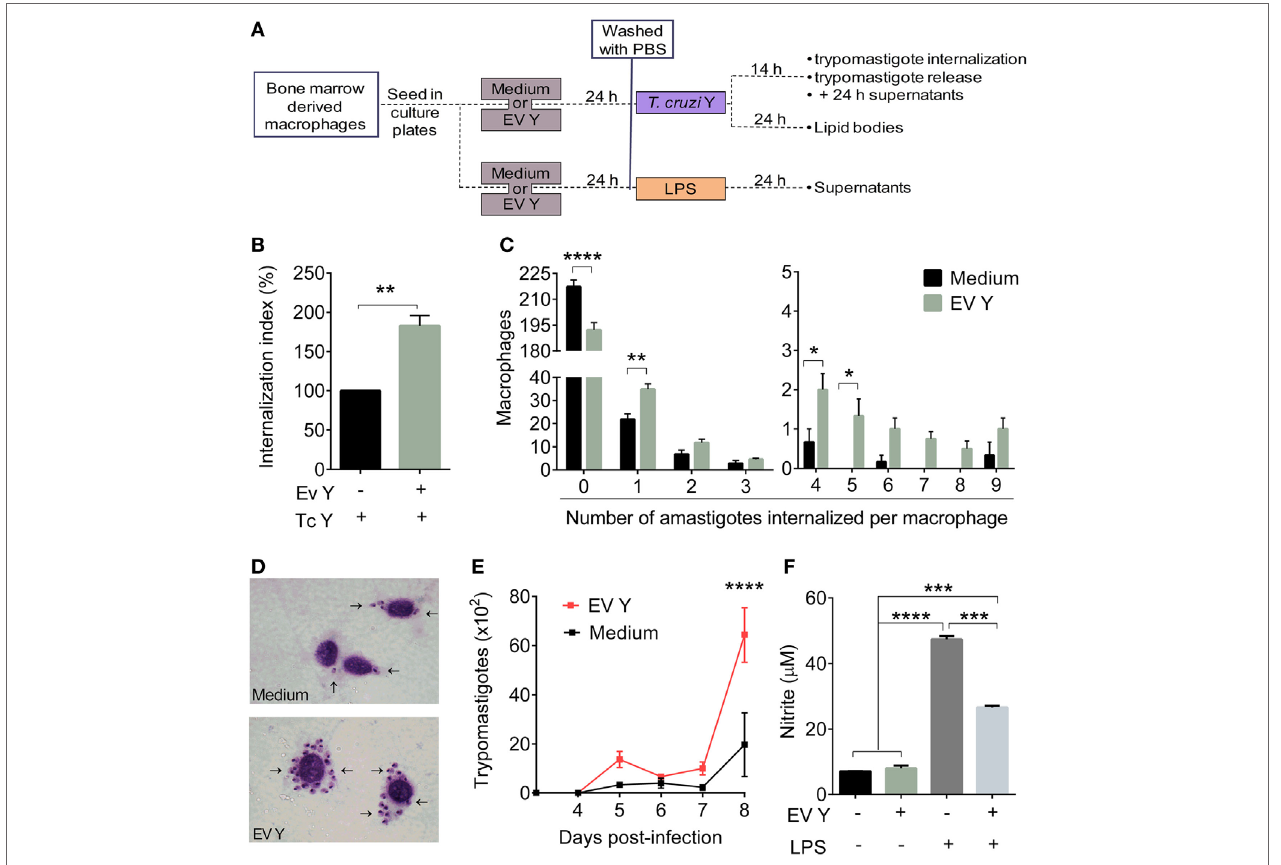
FigUre 6 | Macrophage in vitro stimulation with Trypanosoma cruzi extracellular vesicles (EVs) increases T. cruzi infection and trypomastigote release from infected cells but decreases nitric oxide release. Bone marrow-derived macrophages were incubated for 24 h with EVs derived from T. cruzi Y (EV Y) (i.p.). The cells were washed and infected with T. cruzi trypomastigote forms (0–1 parasites per macrophage for the trypomastigote release assay and 5 parasites per macrophage in the remaining assays) for 14 h or stimulated with 0.1 µg/mL of LPS for 24 h. After the clearance of non-internalized parasites, the cells were stained with Giemsa and analyzed by light microscopy. (a) Experimental design for macrophage in vitro assays (B) The internalization index was calculated considering the number of amastigotes internalized per macrophage. The internalization frequency of the control group, the absence of EV Y (black bar), was considered 100%. The gray bar represents macrophages stimulated with EV Y before T. cruzi infection. (c) The number of internalized amastigotes by macrophage in 250 counted cells. (D) Representative pictures of macrophages stained with Giemsa at 1000 × magnification of infected cells in both groups (control and EV Y). Arrows indicate the internalized amastigotes in macrophages. (e) Daily number of trypomastigotes free in the supernatants. (F) Nitrites in the supernatants of macrophages cultured with LPS were quantified by the Griess assay. The results are expressed as the mean ± standard error from each group in triplicate analysis in an experiment representative of two similar experiments. * P < 0.05; ** P < 0.01; *** P < 0.001; **** P < 0.0001 significantly different. (a) Student’s t- test, (B,D) two-way ANOVA with Sidak’s post-test and (e) one-way ANOVA with Tukey’s post-test—GraphPad